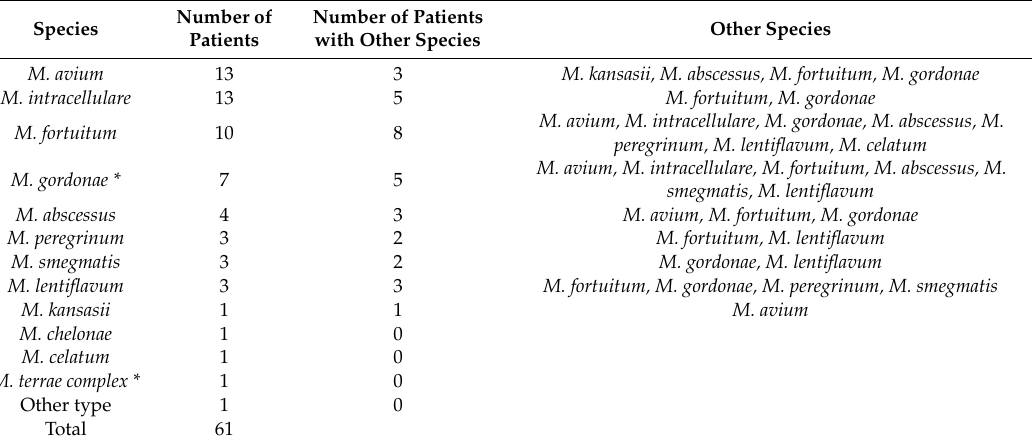
Table 4. NTM infected patients with species